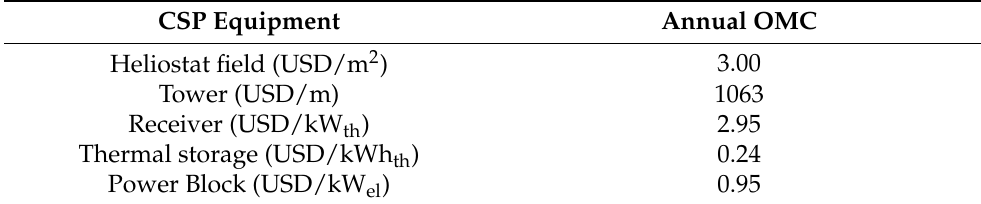
Table 8. Annual CSP operating and maintenance